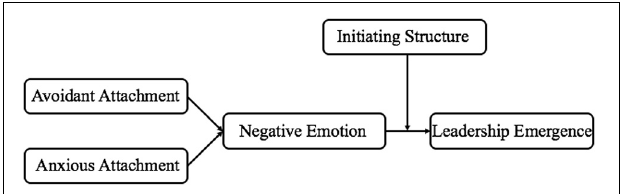
FIGURE 1 | Conceptual model of the